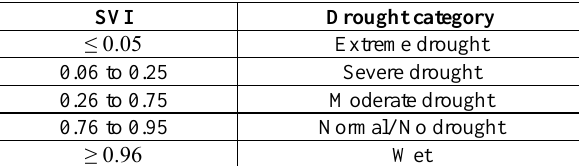
Table 2. Thresholds related to vegetation anomalies using the standardized vegetation index (SVI) based on rainfall data.